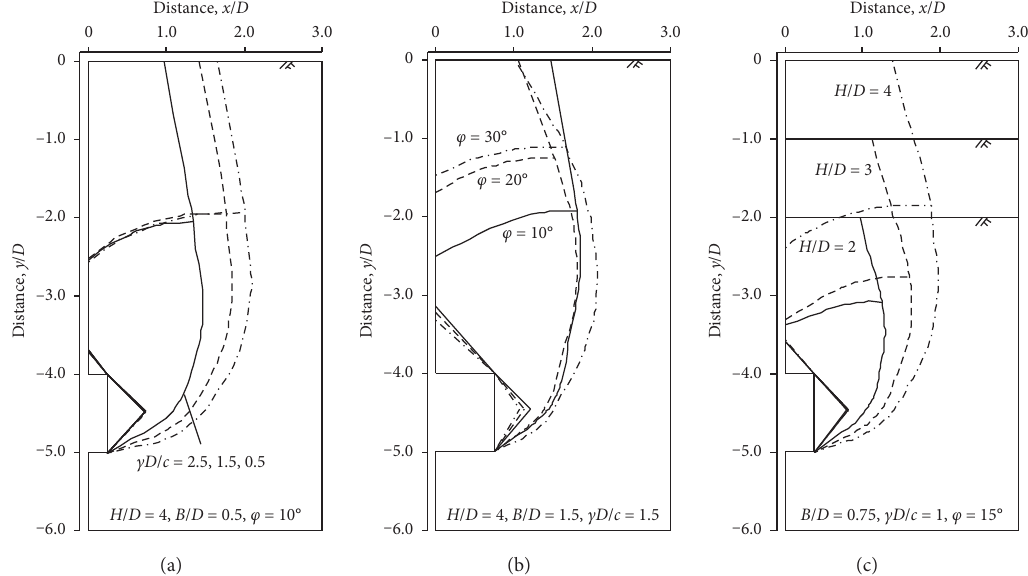
Figure 6: Variation in the failure mechanisms with c D / c , φ , and H/D. (a) H / D � 4, B / D � 0.5, and φ � 10 ° . (b) H / D � 4, B / D � 1.5, and c D / c � 1.5. (c) B / D � 0.75, c D / c � 1, and φ � 15 °